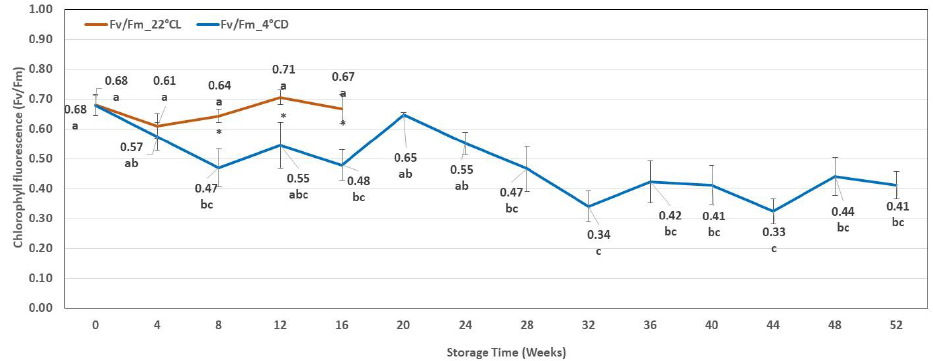
Figure 5. F v /F m values measured on shoots after different periods of cold storage (F v /F m _4 ◦ CD) and of storage in the growth chamber (F v /F m _22 ◦ CL). Line graphs present mean values ± SE of F v /F m. Lower case indicates the significant differences between the F v /F m measured after different storage times. * indicates significant differences between the F v /F m values measured after different storage conditions.